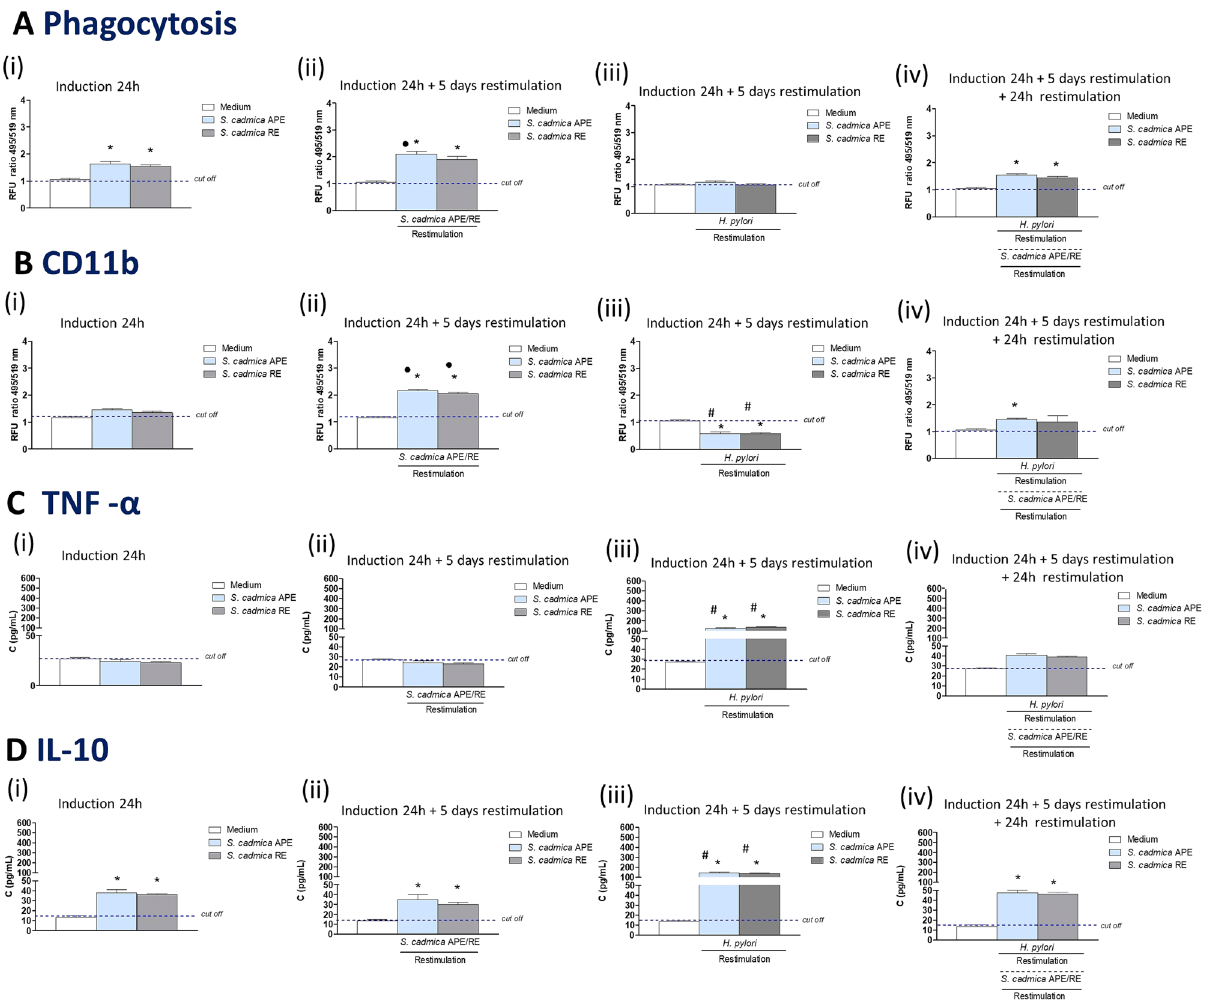
Figure 7. Increased phagocytic activity and downregulation of secretory activity of guinea pig bone marrow macrophages primed and then restimulated with S. cadmica extracts in vitro. The guinea pig bone marrow derived macrophages (BMDM) were treated with S. cadmica aerial part (APE) or roots (RE) extracts alone for 24 h (i), restimulated for 5 days with the homologous plant extract (ii) or H. pylori (iii), and for additional 24 h with S. cadmica extract (iv). ( A ) Phagocytosis towards Escherichia coli was determined on the basis of relative fluorescence units (RFU) ratio in relation to phagocytic activity of control cells in culture medium alone. The results are presented as median relative fluorescence units (RFU) ratio ± range. ( B ) Deposition of CD11b cell surface integrin was determined by the immunofluorescence staining of cells with anti-CD11b antibodies and showed as median RFU ratio ± range. The fluorescence intensity was measured in a MultiscanEX reader at 495 nm (excitation) and 519 nm (emission). ( C ) The level of tumor necrosis factor (TNF)-α and ( D ) interleukin (IL-10), was assessed in cell culture supernatants by the enzyme linked immunosorbent assay—ELISA (pg/ mL), and presented as median values ± range. Statistical significance for p < 0.05 in the non-parametric Mann– Whitney U test. *Cells treated stimulators vs. control cells in culture medium alone; filled circle—cells induced with S. cadmica extract (24 h) vs. cells induced with S. cadmica extract (24 h) and restimulated with S. cadmica extract (5 days); #cells induced with S. cadmica extract (24 h) vs. cells induced with S. cadmica extract (24 h), restimulated for 5 days with H. pylori ; #cells induced with S. cadmica extract (24 h) vs. cells induced with S. cadmica extract (24 h), restimulated for 5 days with H.